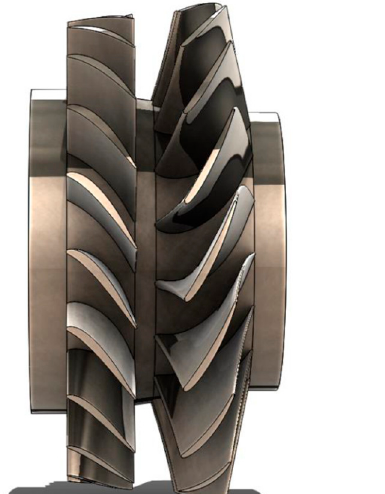
Figure 14. Visual comparison between preliminary blade (left) and optimised blade (right) designs.